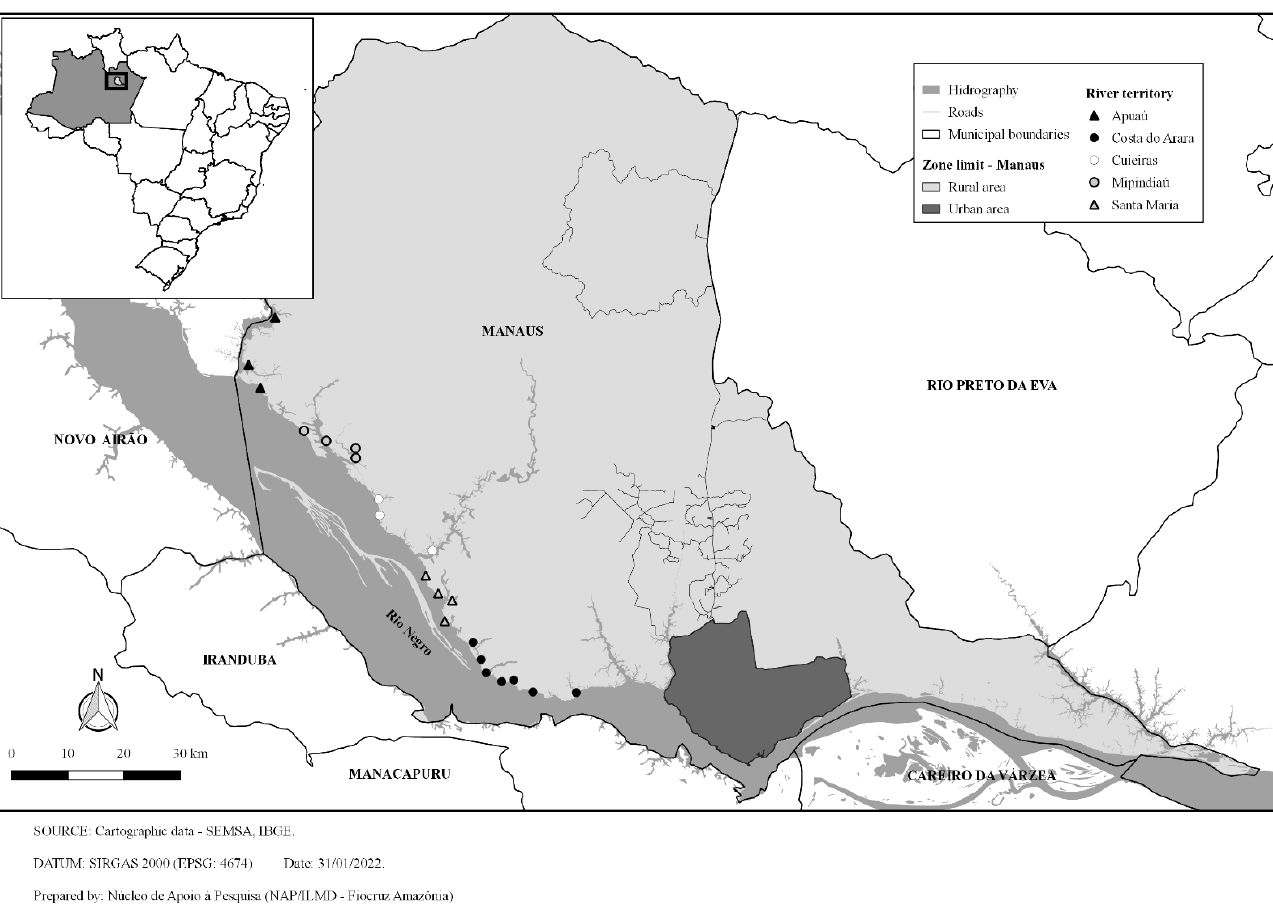
Figure 1. Riverside rural locations covered by the